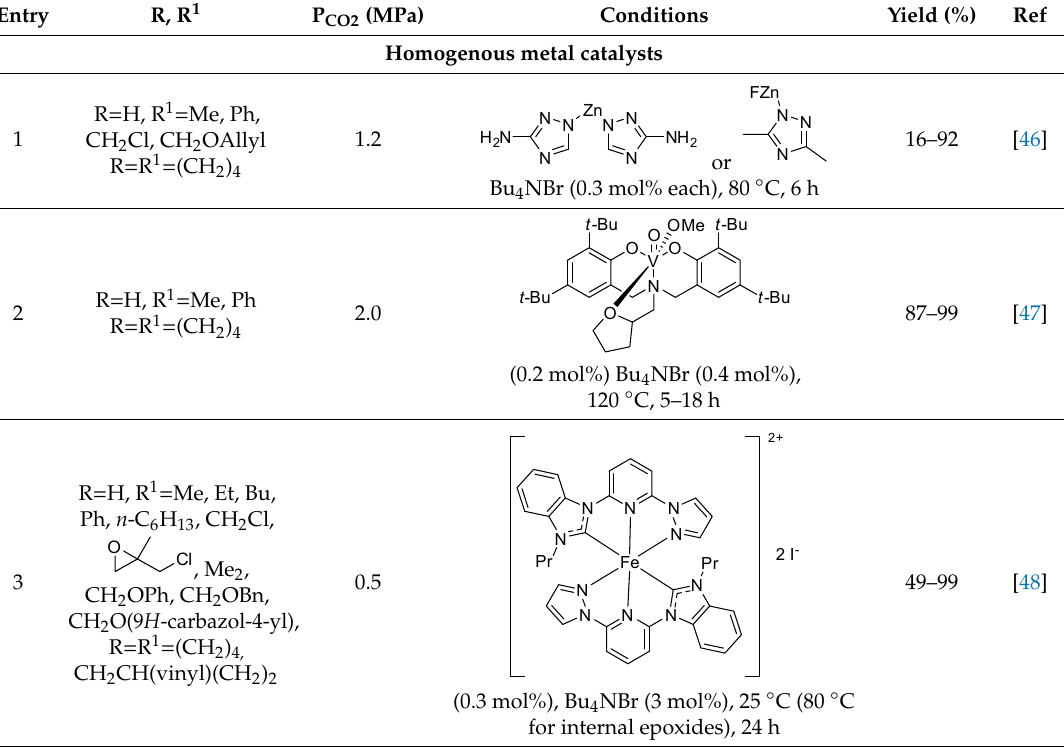
Table 1. Catalysts for the reaction of epoxides and carbon dioxide (R and R 1 see Scheme 2).